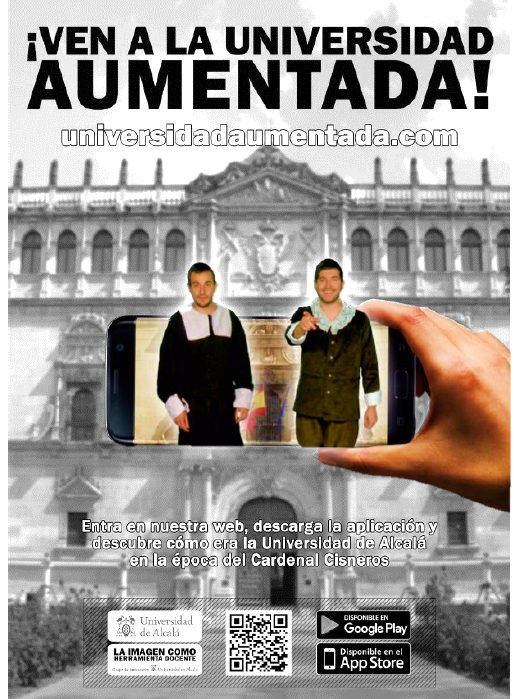
Figure 2. Announcement poster of the application. “universidadaumentada.com”.